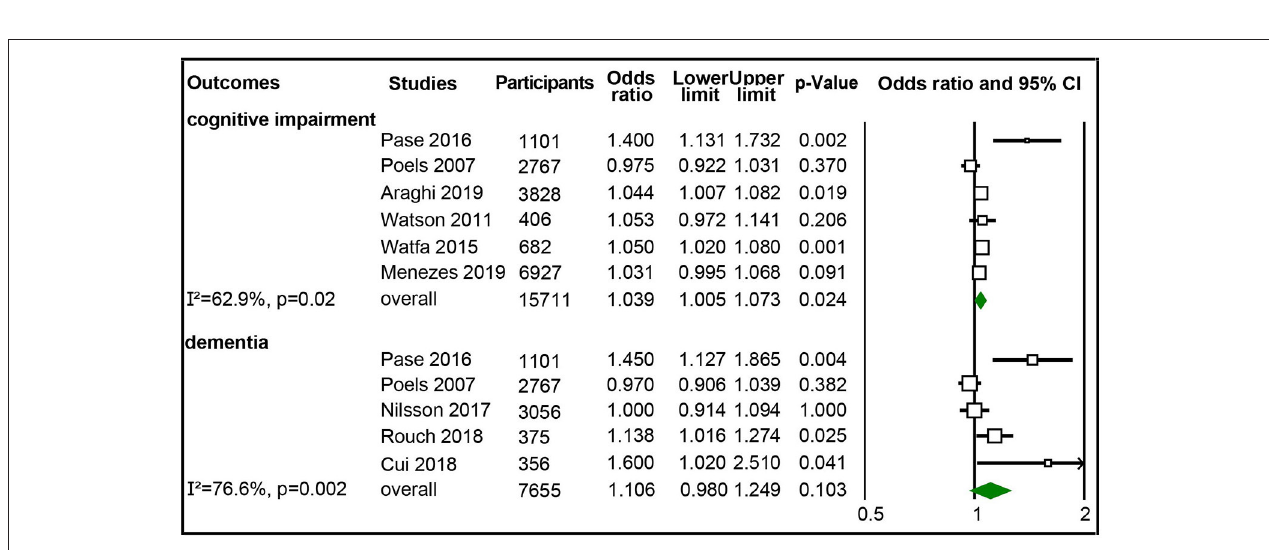
FIGURE 3 | Forest plot of association between categorical aortic pulse wave velocity (PWV) (high vs. low) and cognitive impairment and dementia.